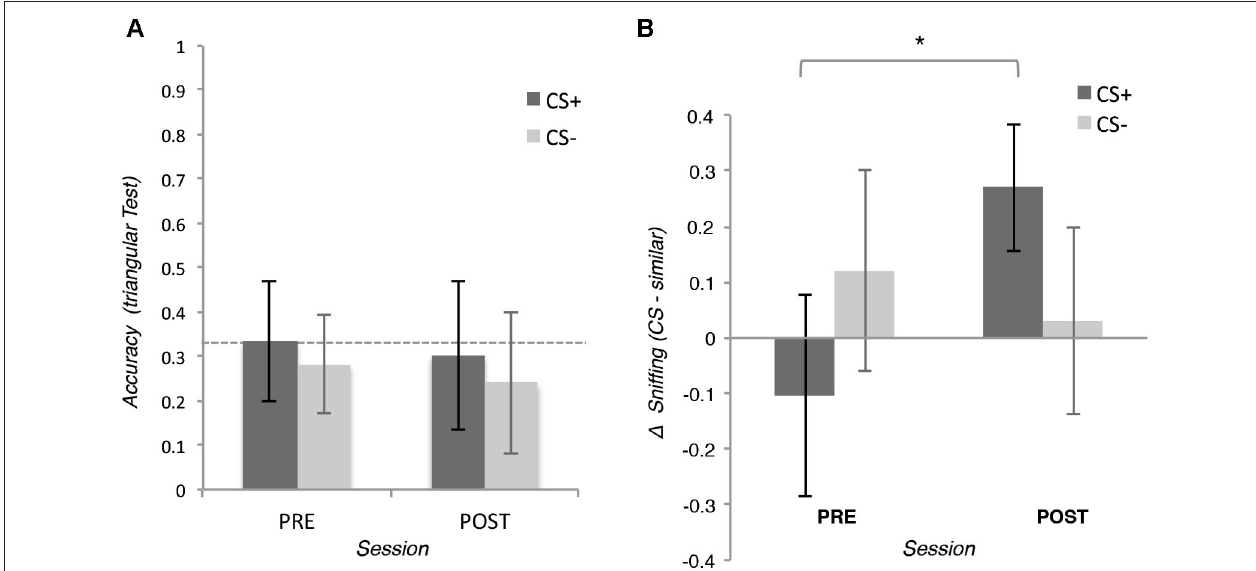
conditioned pair, neither of the two odors (CS − and CS − similar) was associated with the reward. (B) Means of the integral of the volume of the inspiration during the triangular tests. Error bars ( ± 1 SEM ) are adapted for within design (Cousineau,